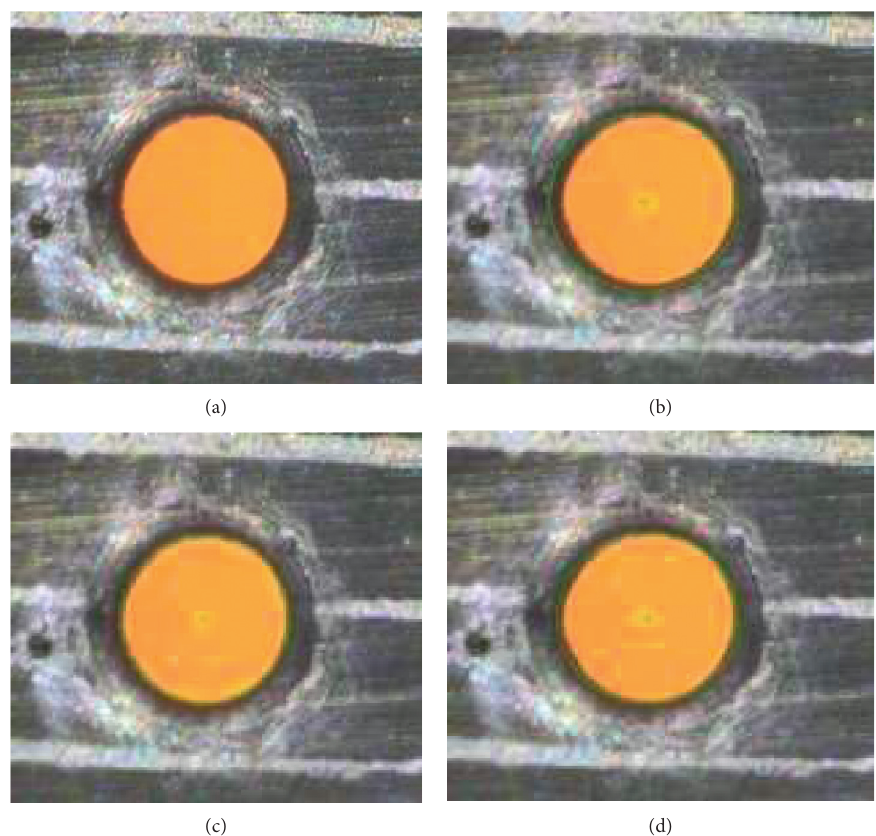
Figure 11: Edge image of detection result. (a) Picture of compensation hole. (b) Random Hough transform. (c) Gradient Hough transform. (d) This paper algorithm.